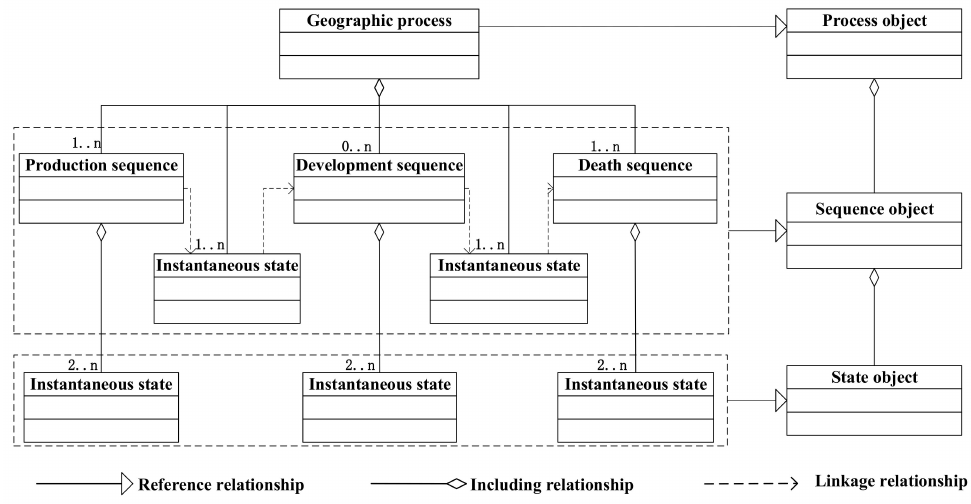
Figure 2. The concept model of the geographic